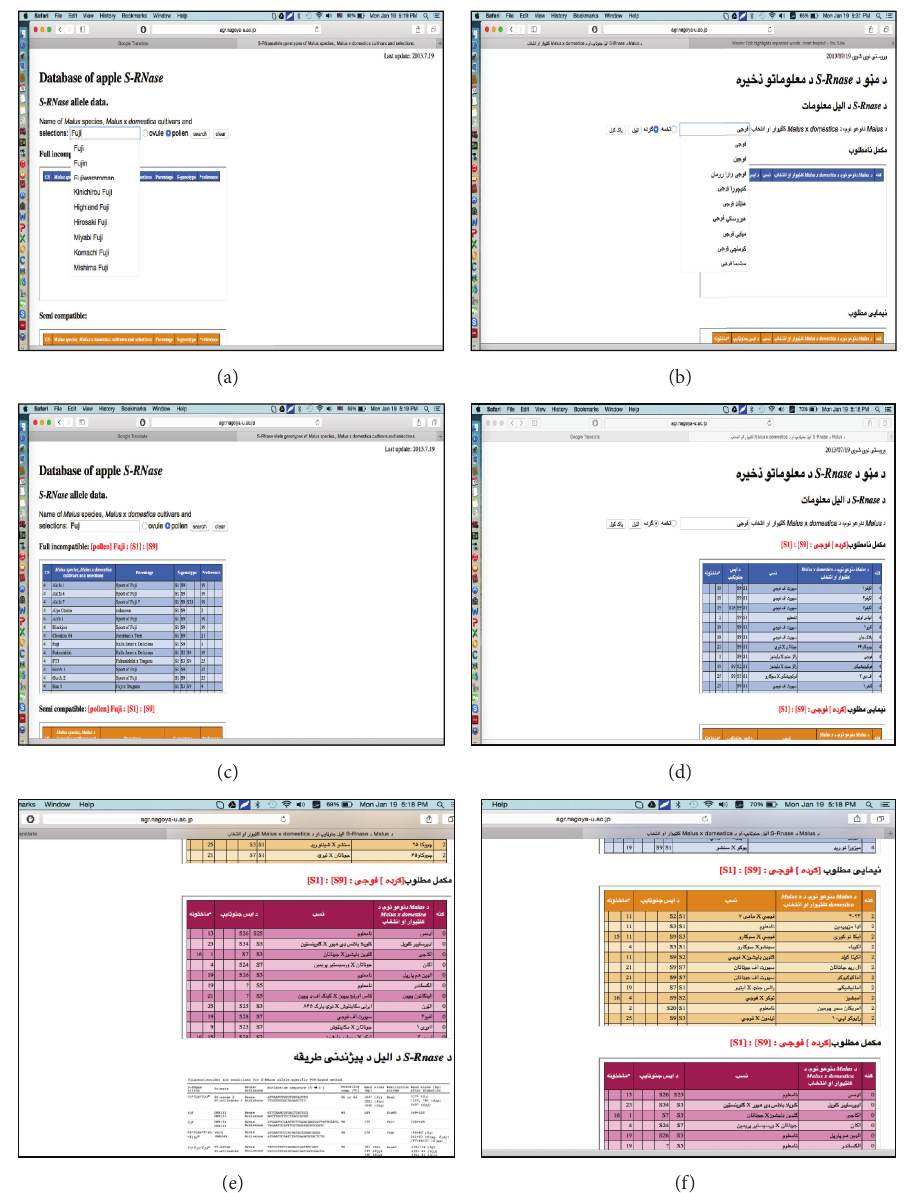
Figure 2: Pashto language version of representative screenshots of the search system. “Fuji” was selected for searching cultivars on the English version(a)andPashtoversion(b).Searchresults:cultivarsincompatiblewith“Fuji”ontheEnglishversion(c)andPashtoversion(d),cultivars semicompatible with “Fuji” on the Pashto version (e), and cultivars fully compatible with “Fuji” on the Pashto version